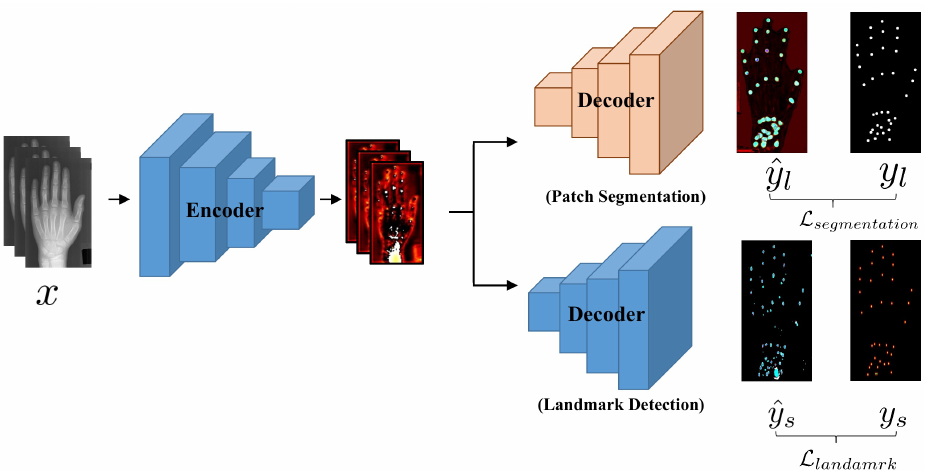
Figure 2. The multi-task learning framework for teacher model pretraining: There are two branches: the segment branch (top) and the landmark detection branch (bottom). The segment branch processes a medical image to predict a segmented mask and the landmark branch predicts a heatmap as shown in Figure 3.